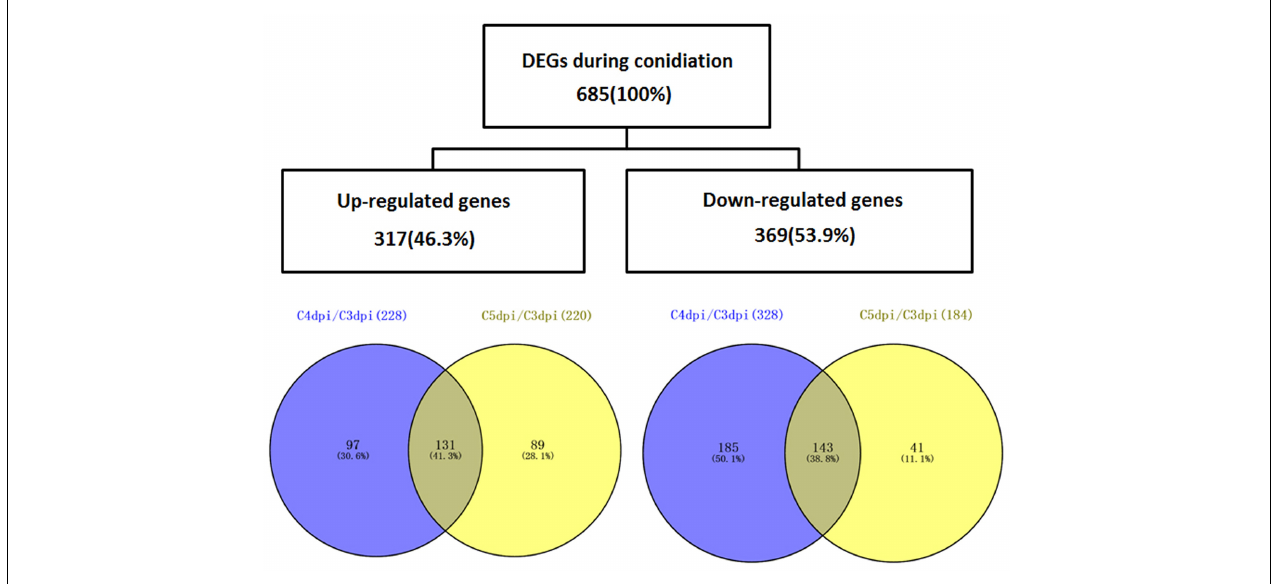
FIGURE 2 | A Venn diagram illustrating the numbers of DEGs of Bgt during conidiation on Chancellor. The overlaps of DEG sets obtained from the comparison C4 dpi/C3 dpi and C5 dpi/C3 dpi are